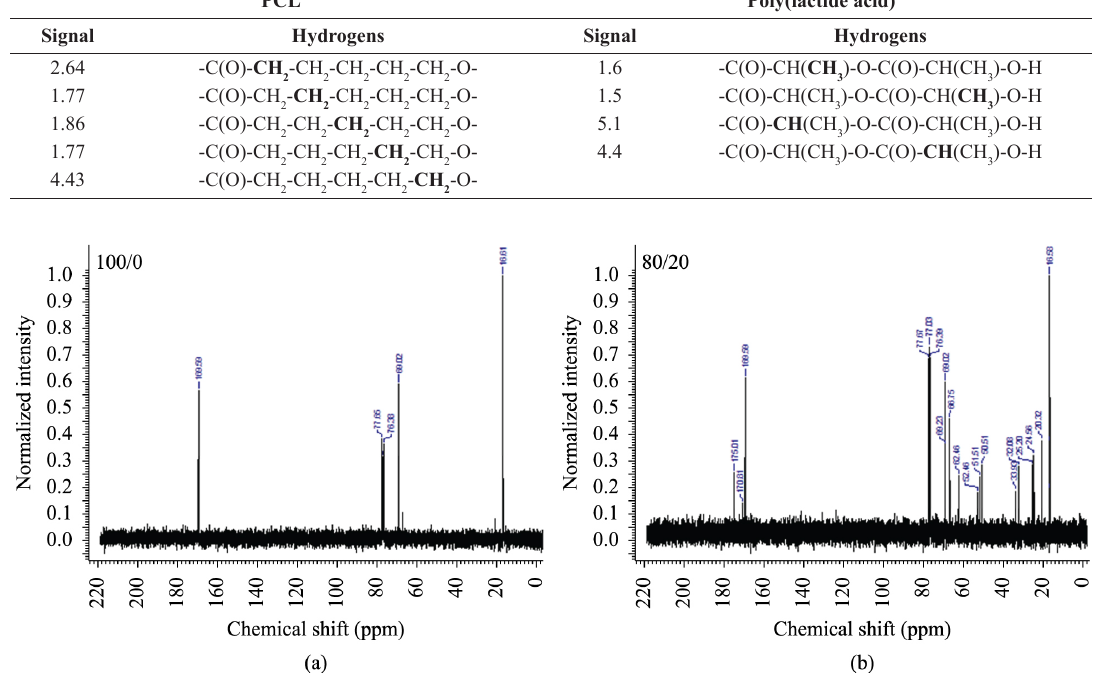
Figure 2. 13 C-NMR spectra for samples of (a) PLLA (100/0) and (b) PLLA-co-PCL (80/20).